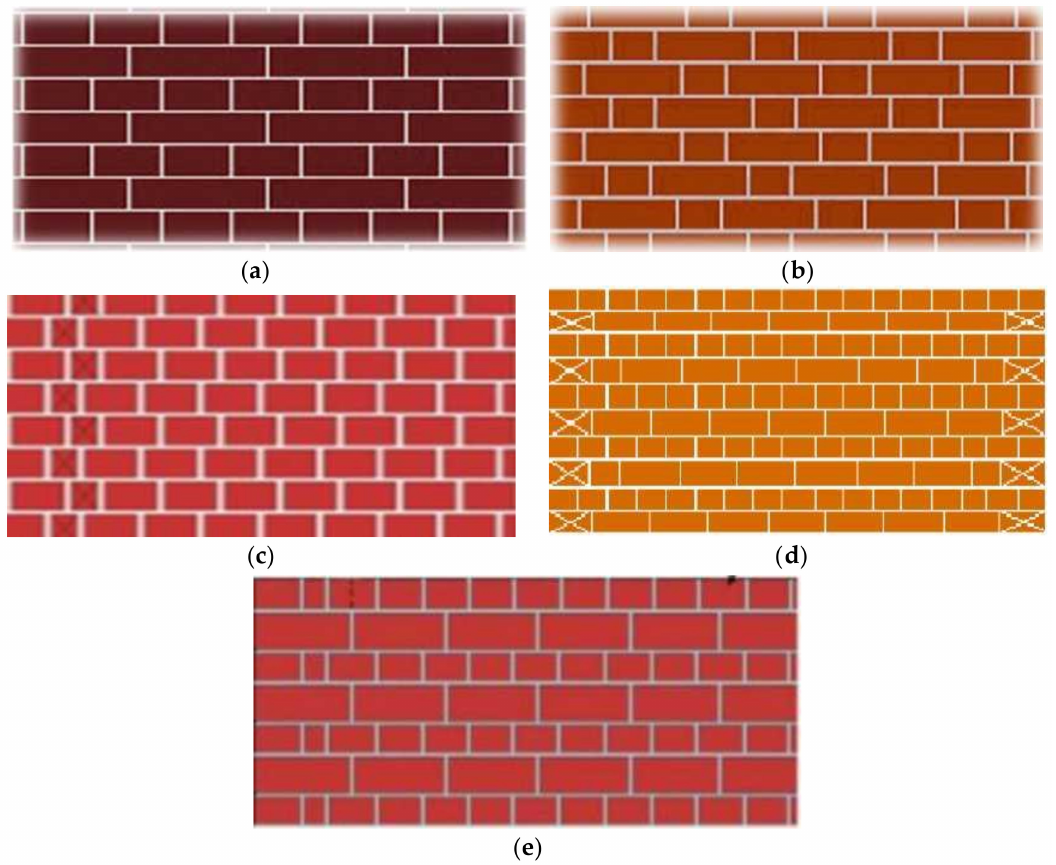
Figure 1. Types of masonry bonds [1,34]: ( a ) English bond; ( b ) Flemish bond; ( c ) header bond; ( d ) Dutch bond; ( e ) silver-lock bond. Note: Changes in colour do not represent any change in brick type and are only to distinguish between bond